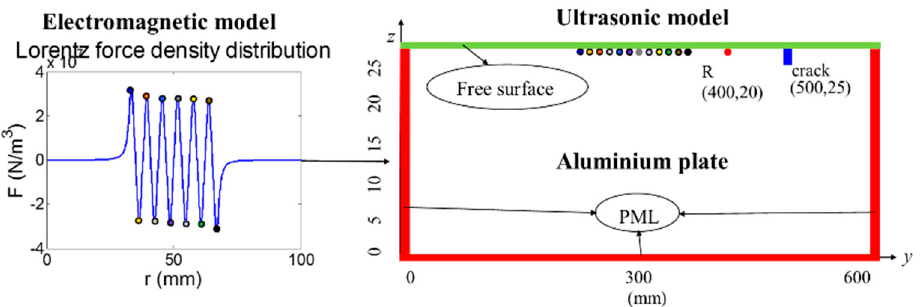
Figure 6. On the vertical plane of the material, the combination of the EMAT-electromagnetic (EM) and EMAT-ultrasonic (US) models. Reproduced with permission from [15], IEEE, 2016.